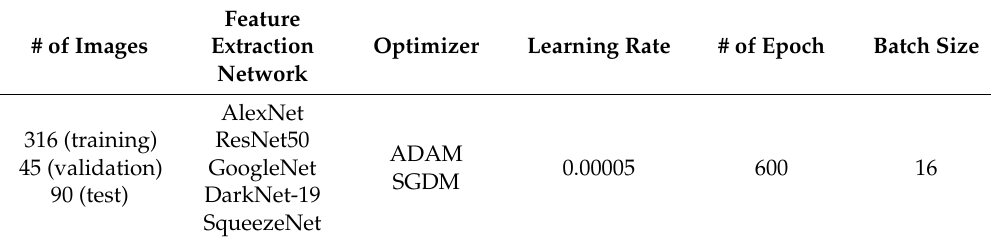
Table 3. Detailed training option.